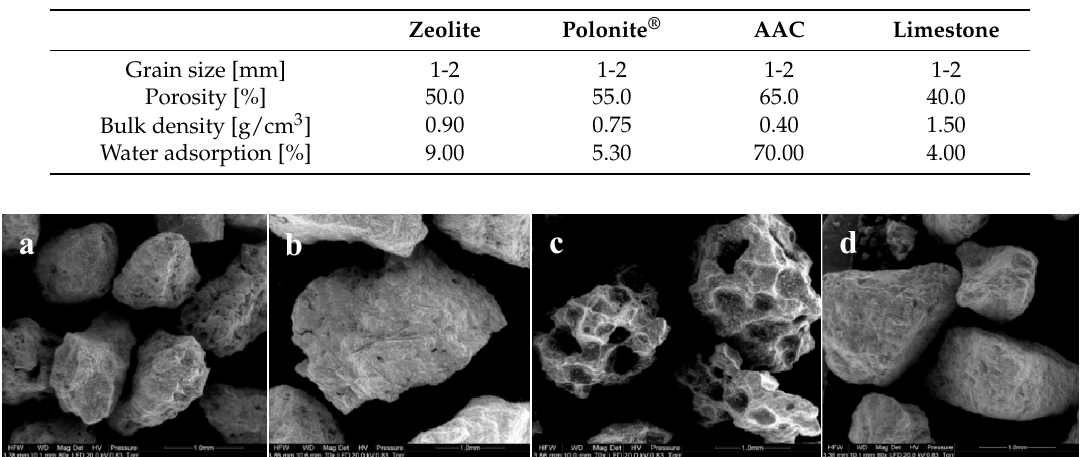
Figure 1. Scanning electron microscope (SEM) micrographs of ( a ) zeolite; ( b ) Polonite ® , ( c ) AAC, ( d ) Limestone.